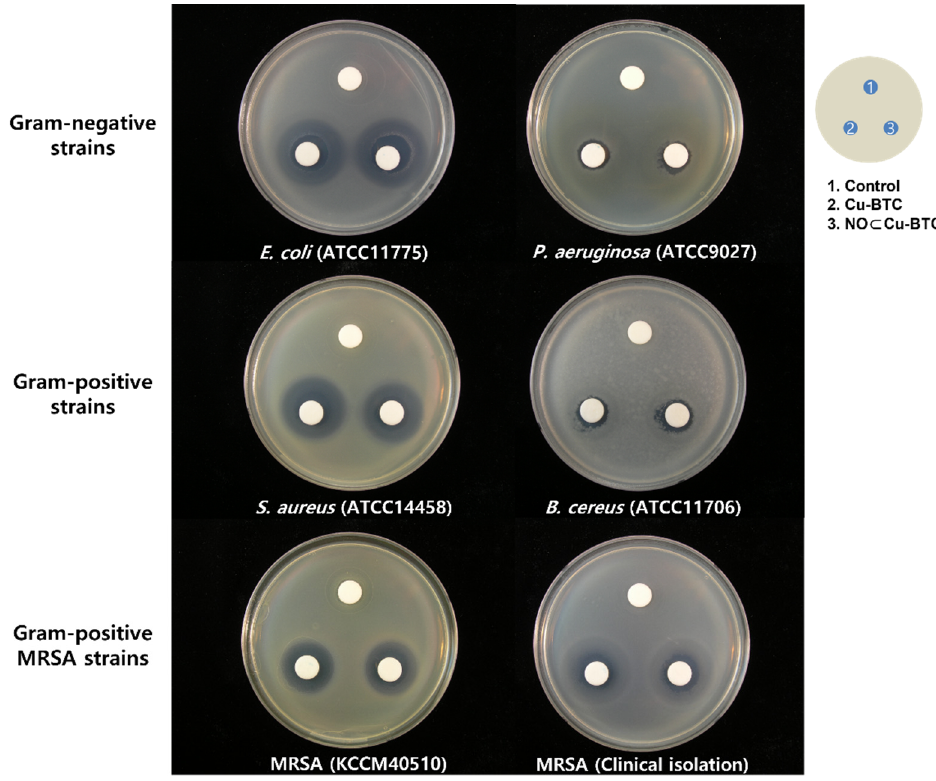
Figure 11. Inhibition zone assay of Cu-BTC (BTC: benzene-1,3,5-tricarboxylate) and NO ⊂ Cu-BTC (NO: nitric oxide) toward six strains of bacteria tested by disc diffusion method. Table 3. Inhibition zone of Cu-BTC and NO ⊂ Cu-BTC toward six strains of bacteria.